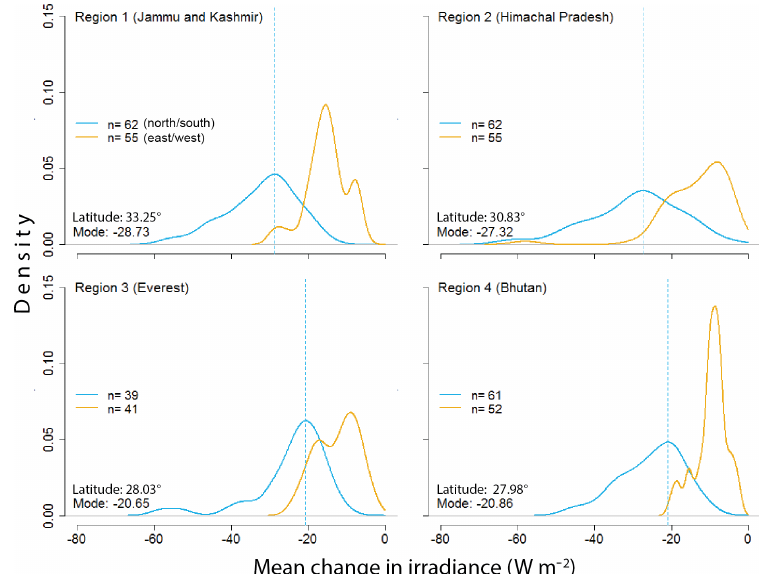
Figure 9. Regional analysis spanning glaciated basins throughout the greater Himalaya of HMA. A mean value for change in irradiance due to cast shadowing is calculated for the ablation zone of each glacier within each region. We see that the distribution for north/south glaciers are more impacted by cast shadowing than east/west glaciers. Only values below mean glacier elevation were used to calculate the mean change for each glacier. Additionally, we see that the peak value for mean change in irradiance is greater in regions of higher latitudes (regions 1 and